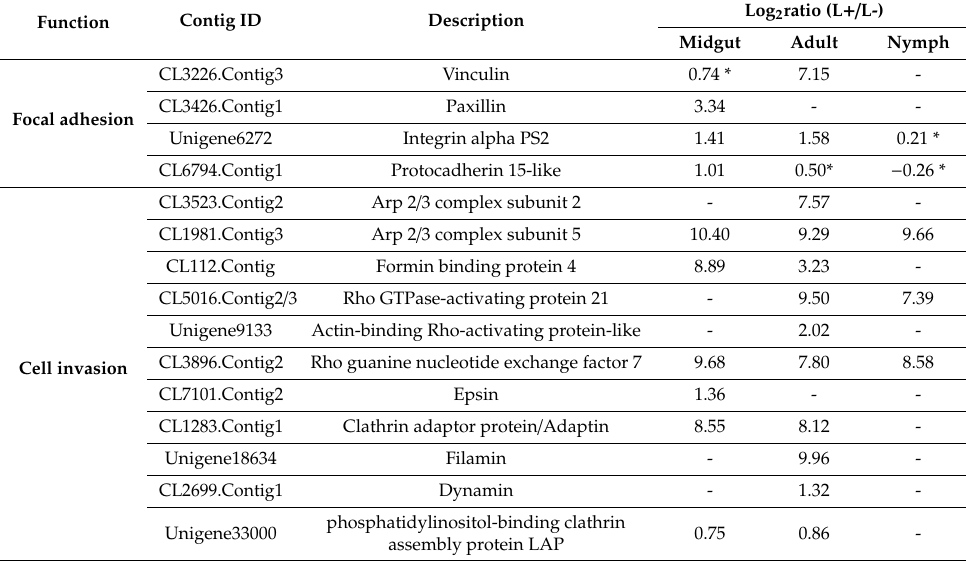
Table 4. Di ff erentially expressed genes (FDR ≤ 0.001) between CLso-infected and uninfected midguts, adults, and nymphs related to CLso